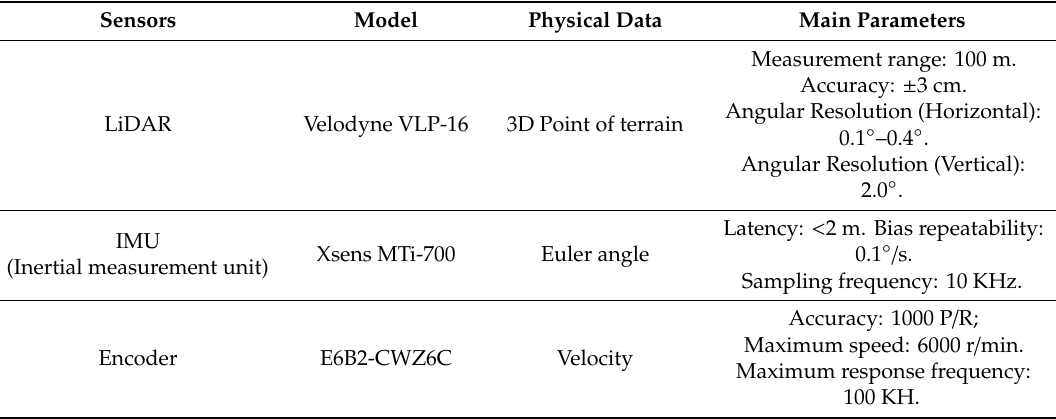
Figure 18. Mobile light detection and ranging (LiDAR) point-cloud data acquisition system. Table 1. The main parameters of the sensors.